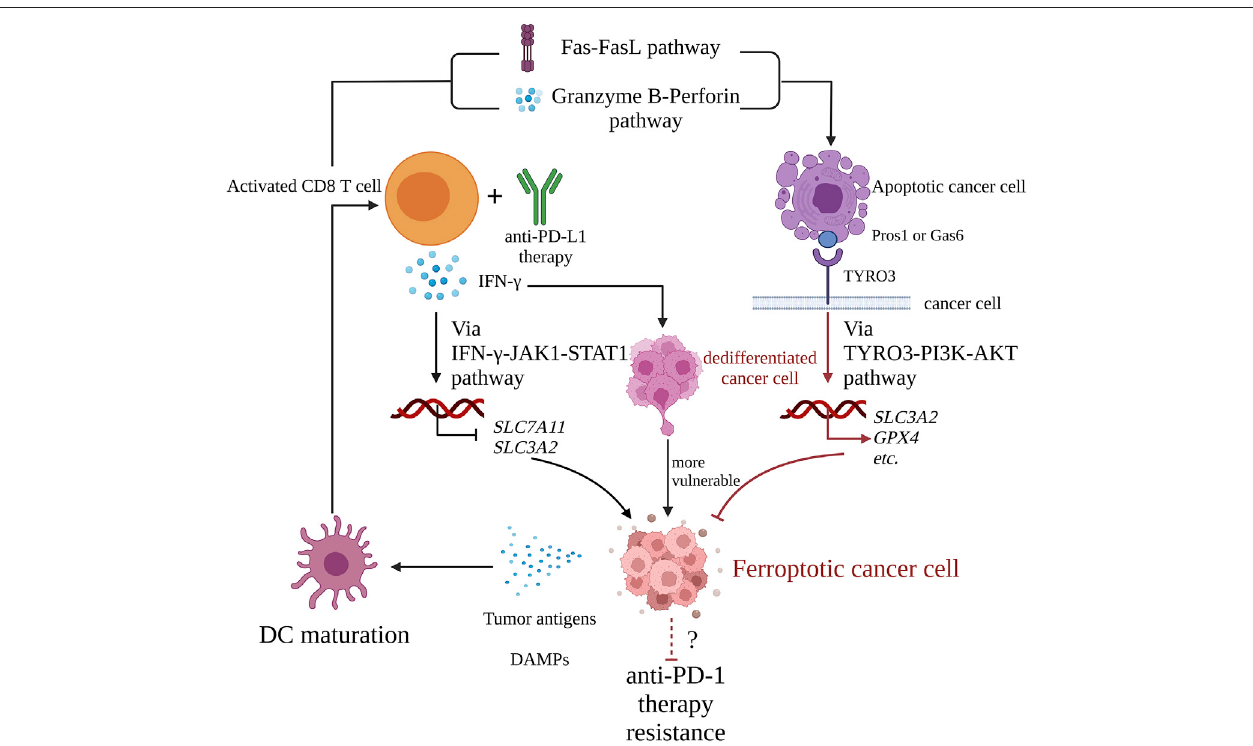
FIGURE 3 | The interaction cycle of ICI therapy and ferroptosis. Activated CD8 T cells with anti-PD-L1 therapy release IFN- γ , which downregulates the expression of SLC3A2 and SLC7A11 via the IFN- γ -JAK1-STAT1 pathway and promotes cancer cell ferroptosis. Meanwhile, activated CD8 T cell mediates apoptosis of target cancer cell via Fas-FasL pathway or granzyme B-perforin pathway. The apoptotic cell expresses receptor tyrosine kinase TYRO3 on its membrane. Once TYRO3 binds to Pros1 or Gas6 expressed on apoptotic blebs, TYRO3-PI3K-AKT pathway is activated, which leads to upregulation of pro-ferroptosis genes such as SLC3A2 and GPX4 , inhibition of cancer cell ferroptosis, and cancer cells resistance to anti-PD-1 therapy. Ferroptotic cancer cells are with immunogenicity, and they release DAMPssuchATP,DNA,HMGBandsoon,whichpromoteDCmaturation,acriticallinkofcancer-immunitycycle,and fi nallyexplainingthatferroptosishelpsICItherapy. IFN- γ , interferon- γ ; JAK1, Janus-activated kinase 1; STAT1, signal transducer and activator of transcription 1; Pros1, Protein S1; Gas6, growth-arrest-speci fi c 6; PI3K, phosphatidylinositol-4,5-bisphosphate3-kinase; AKT, protein kinase B; HMGB, high mobility group protein B; DC, dendritic cell; PD-L1, programmed cell death 1; PD- L1, programmed cell death ligand